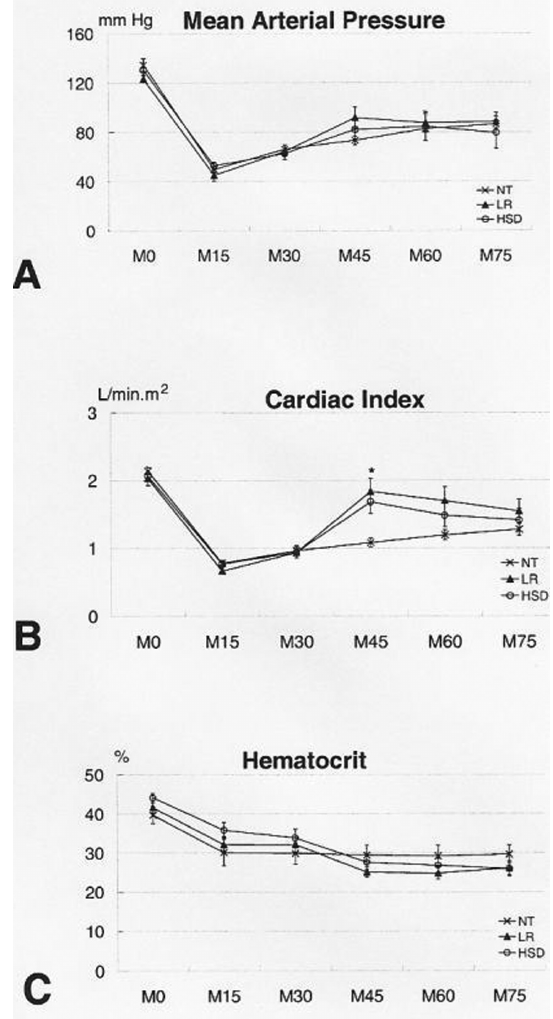
Figure 7 – Panel A – Mean arterial pressure (MAP) decreased significantly during the initial fifteen minutes after the injury, and it increased equally in all groups. Panel B – Reduction in cardiac index (CI) was observed 15 minutes after injury in all groups. After fluid resuscitation, a significant increase in CI was observed in LR- and HSD-treated animals (T45) when compared with the NT group. Panel C – Hematocrit (Htc) was similar in all groups during the experiment. * p<0.05 CT vs. LR and HSD, † p<0.05 CT vs.